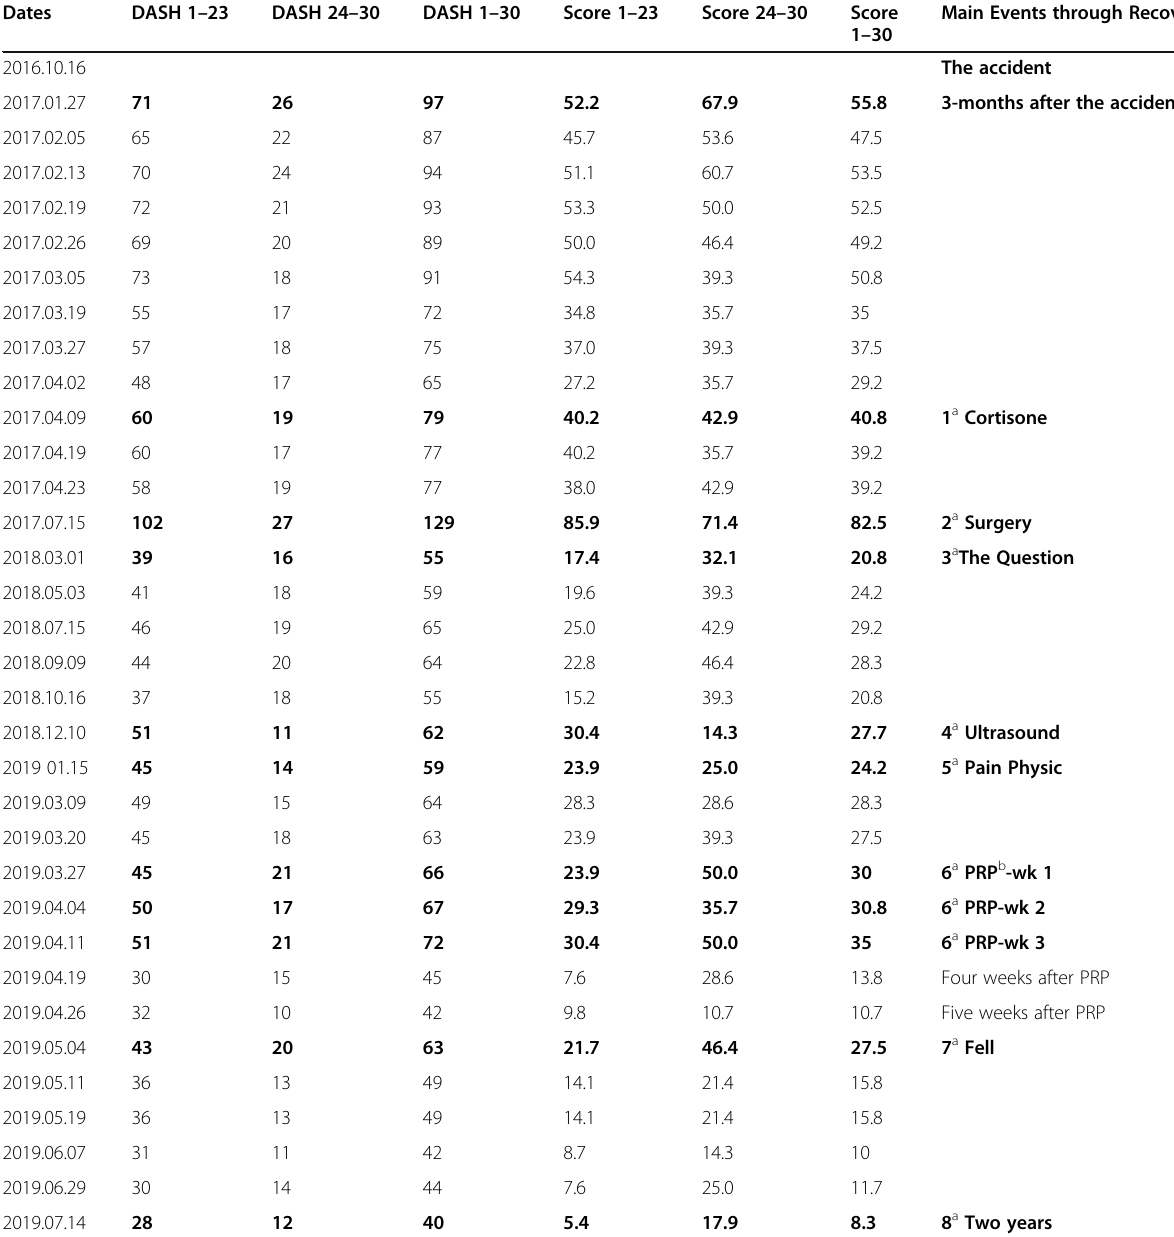
Table 1 Disabilities of the Arm, Shoulder and Hand (DASH) Questionnaire and Scores. Data presented from three months after the accident to two years